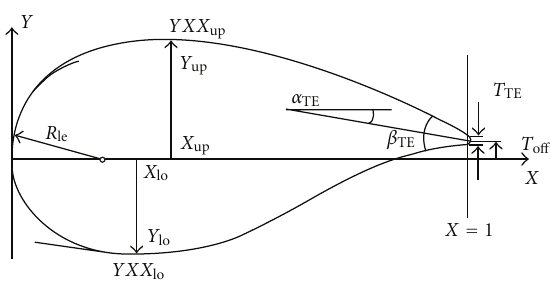
Figure 1: Control variables for PARSEC.